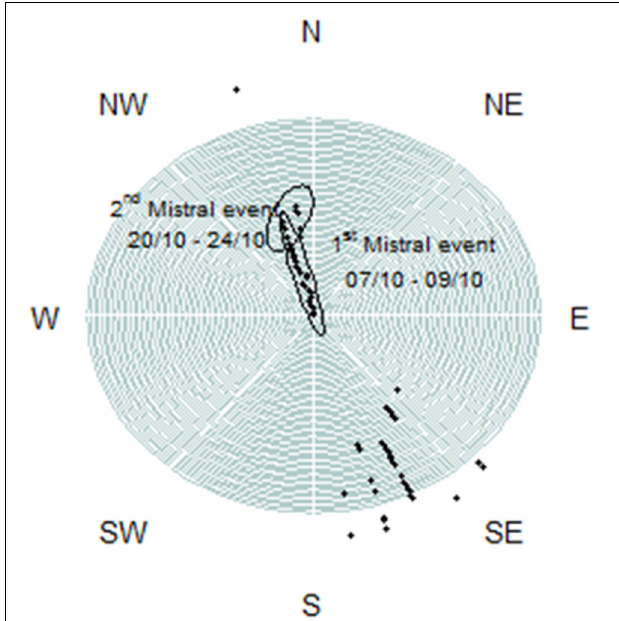
FIGURE 5 | Distribution of wind direction during October 2011 with gusts exceeding 20m/s.